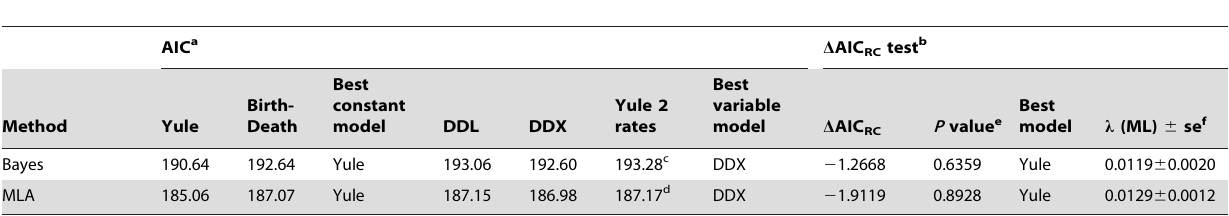
Table 2. Fit of alternative diversity models to LTT plots derived from Bayes and MLA chronograms.